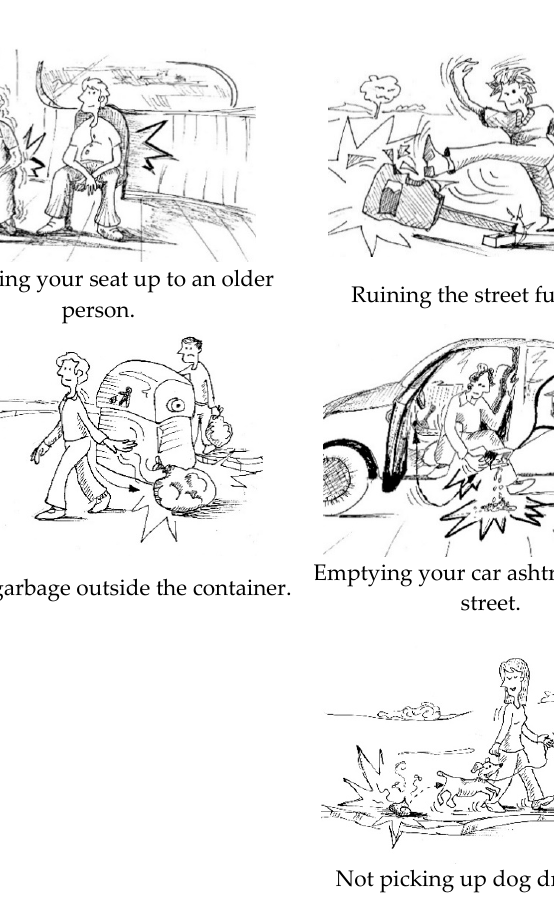
Figure A2. Uncivil pictures.